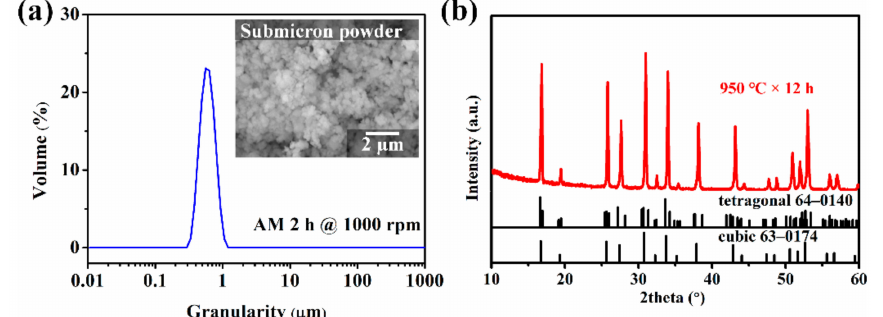
Figure 2. ( a ) Particle-size distribution of the LLZNO powder after being attrition milled 2 h at 1000 rpm and its SEM image and ( b ) XRD pattern of the LLZNO